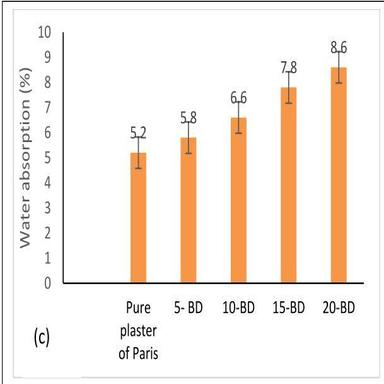
Physico-chemical properties (a) density (b) compression strength, (c) water absorption, (d) thermal conductivity, and (e) tensile strength.